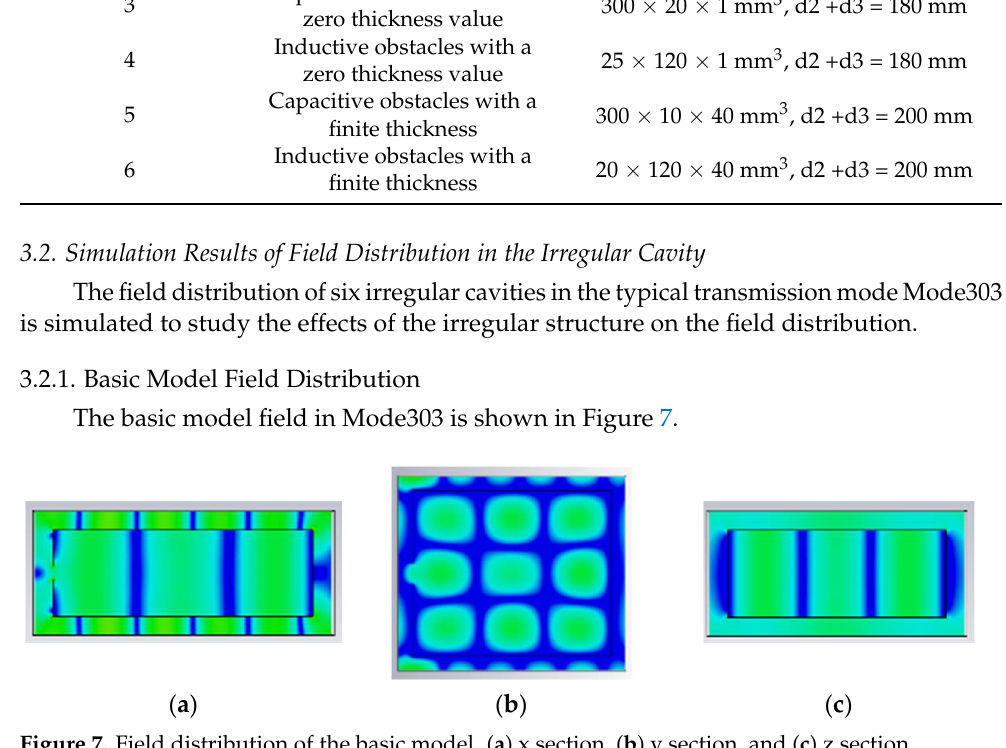
Table 1. The parameters of six irregular structures.